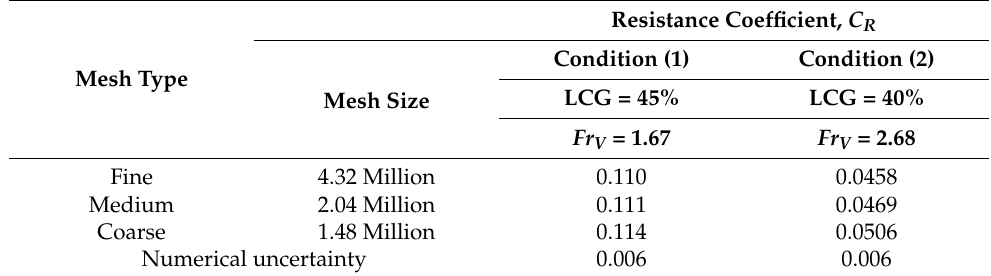
Table 1. Resistance coefficient obtained at three mesh levels and two operating conditions. Resistance Coefficient, C R Condition (1) Condition (2) Mesh Type LCG = 45% LCG = 40% Mesh Size Fr V = 1.67 Fine 4.32 Million 0.110 Medium 2.04 Million